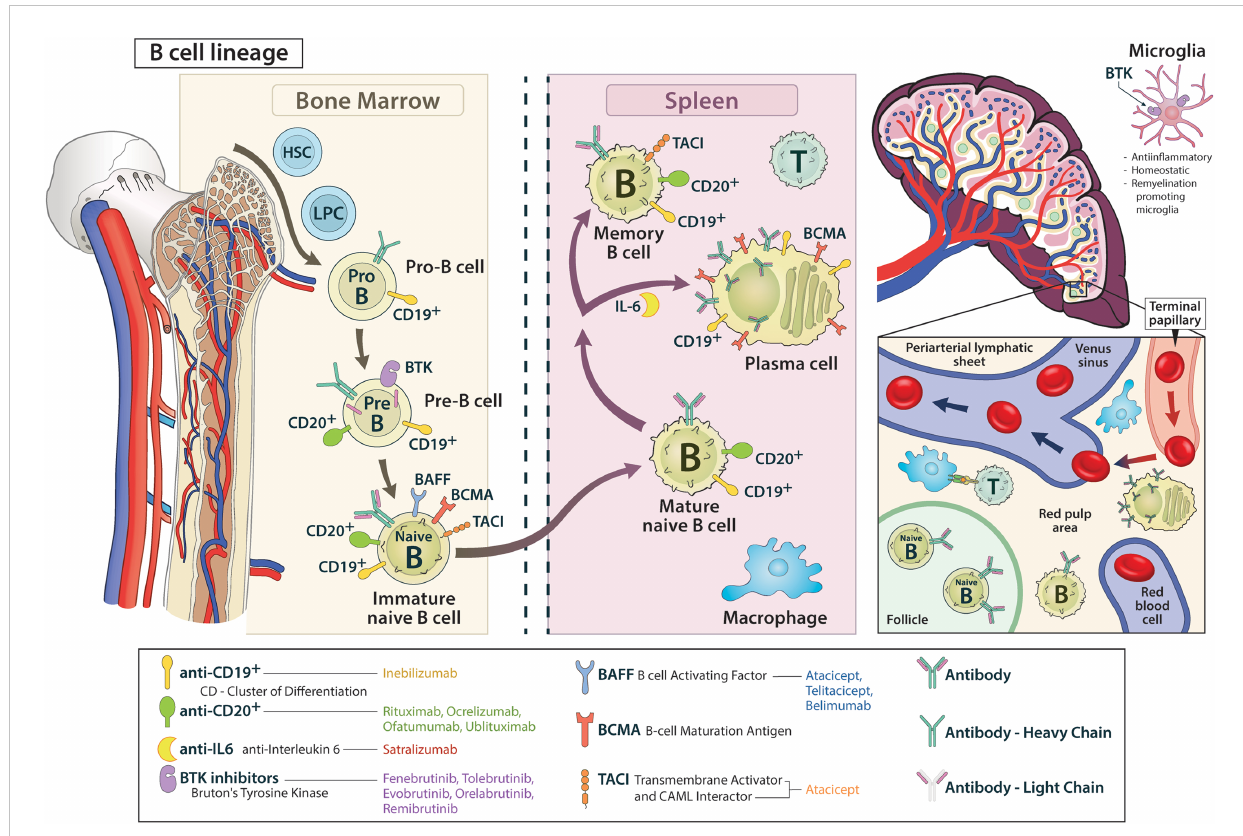
FIGURE 1 The B cell lineage from bone marrow to the periphery is shown, including relevant surface proteins and their targeting by corresponding